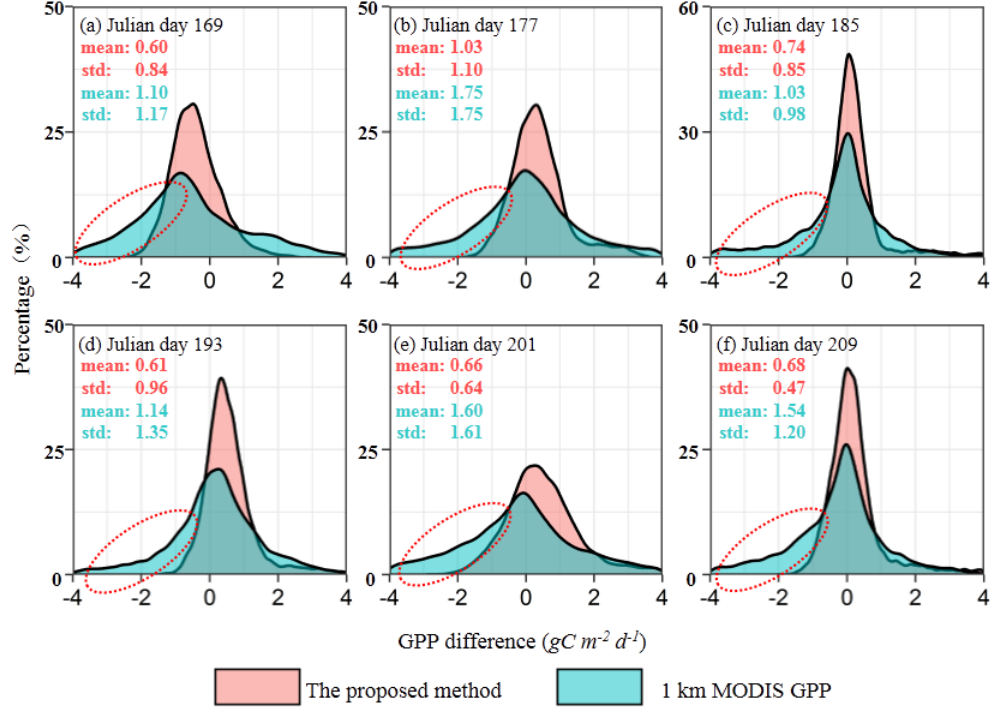
Figure 7. The density distributions concerning the GPP differences between the 500 m MODIS GPP and the downscaled GPP results for Julian days 169–209. Figures ( a – f ) indicate Julian days 169–209, respectively.